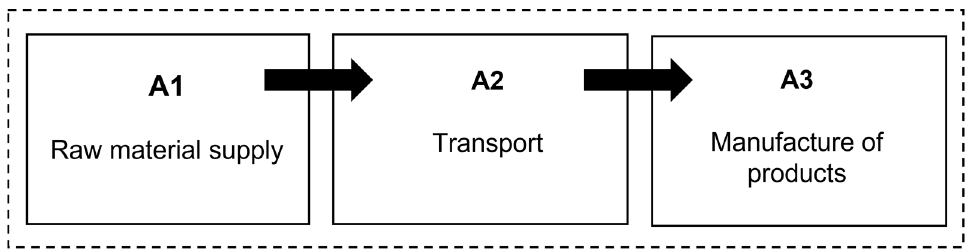
Figure 6. Cradle-to-gate system boundaries. According to EN 15978.